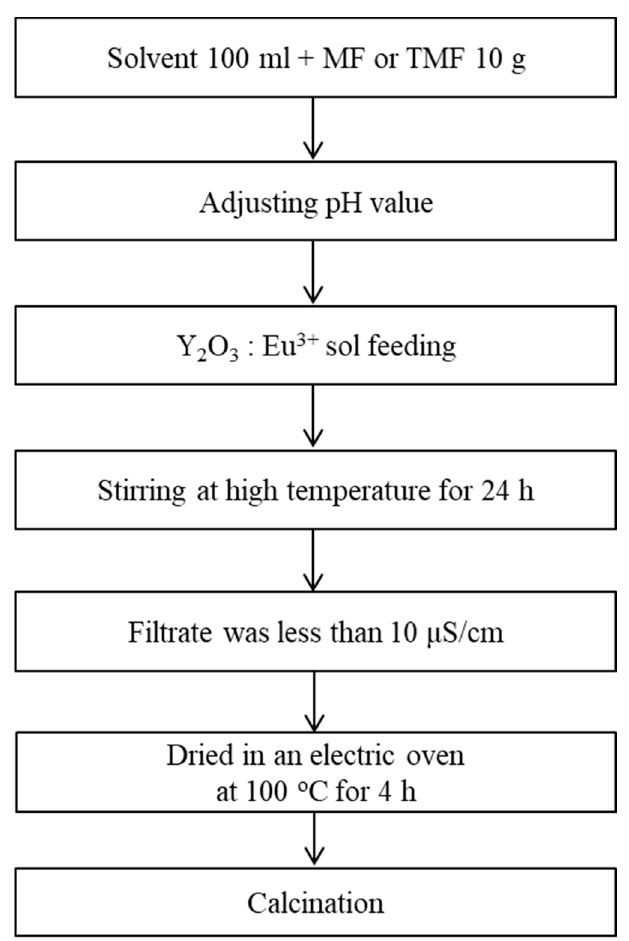
Figure 1. Preparation process of Y 2 O 3 :Eu 3+ red phosphor coated on MF or TMF.